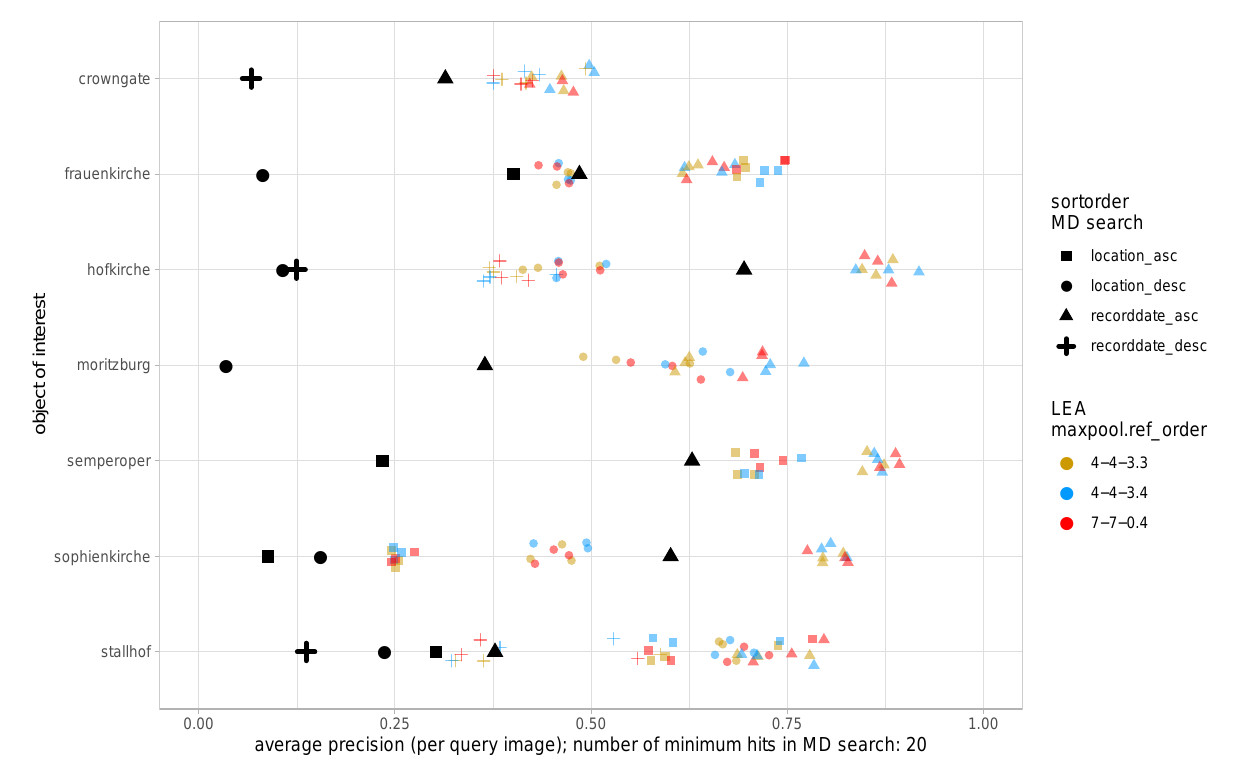
Figure 6. Average precision for MD search and LEA IR over all seven